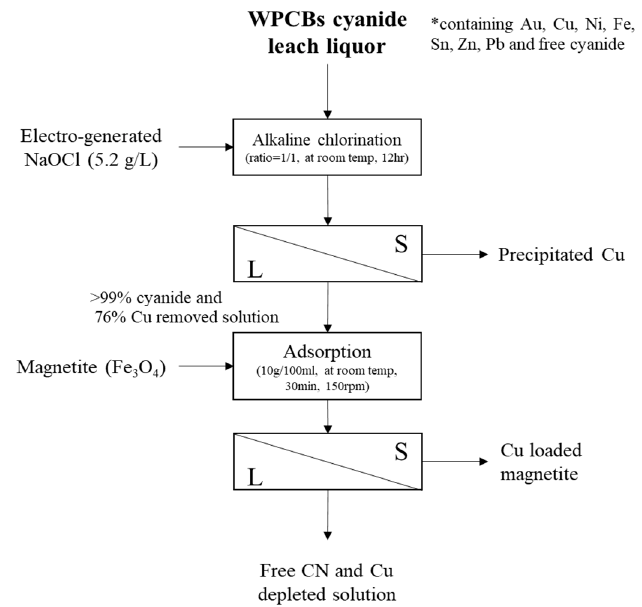
Figure 8. Flow sheet for the removal of cyanide and copper from WPCBs leach solution using electro-generated NaOCl and magnetite adsorption.